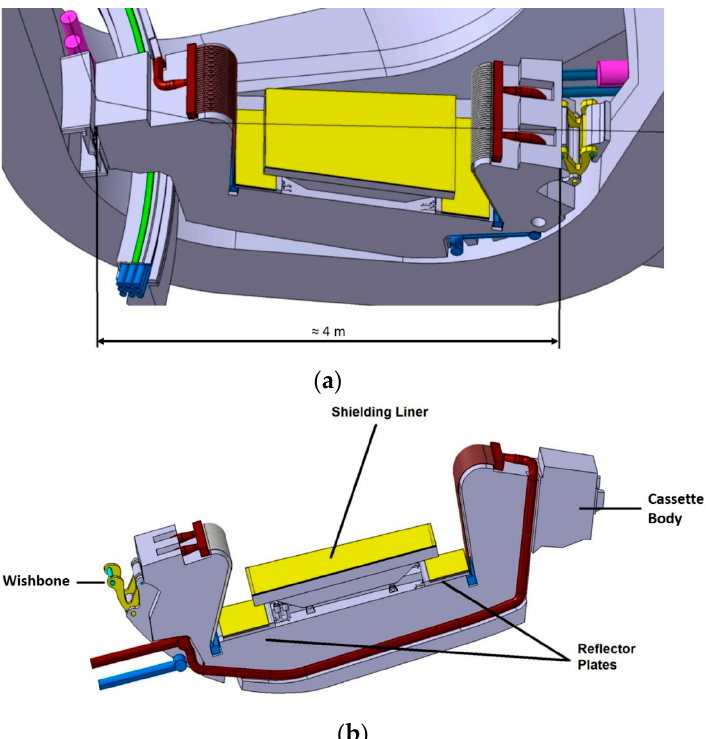
Figure 1. ( a ) Computer ‐ Aided Dsesign (CAD) model of 2019 DEMO divertor assembly, with the length of the divertor [15]; ( b ) CAD model of 2019 DEMO divertor assembly, with main parts [15].